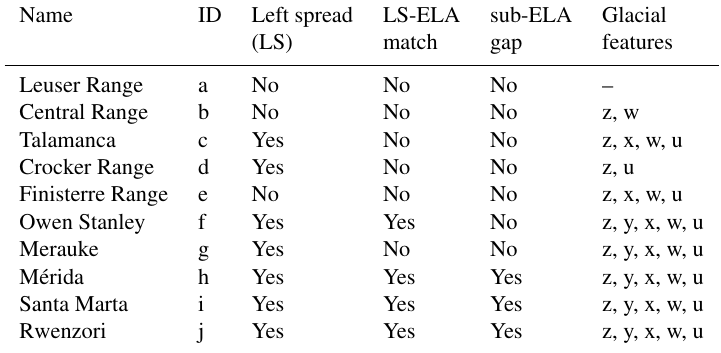
Table 1. Summary of evidence for glacial limitation. Left spread (LS) refers to high-elevation hypsometric maxima with low-elevation outlets in progressive hypsometry (Figs. 8a1–j1, 13c). LS-ELA match: The strength of the match between the left spread and the ELA is assessed in Fig. 8a1–j1. Sub-ELA gap: the sub-ELA gap refers to the absence of left spread below the ELA. Glacial features: z – cirques; y – terminal moraines; x – lateral moraines; w – retreat moraines; u – overdeepenings. Glacial features in each place have been documented in the literature and were confirmed by the authors in the available imagery (e.g., Google